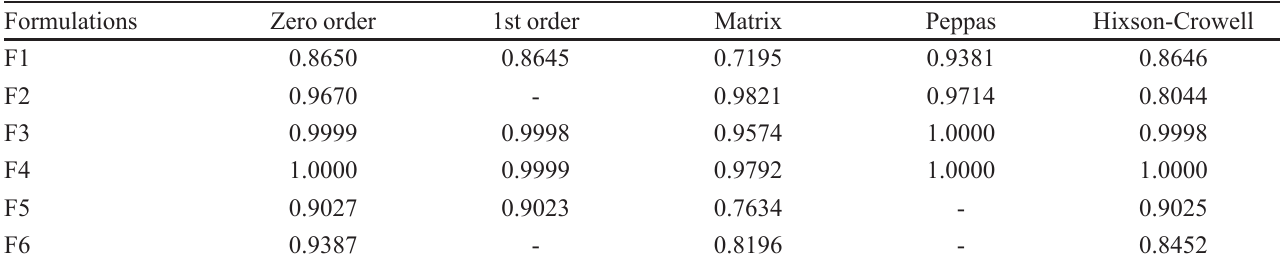
TABLE III - Correlation coefficients (r) for Hot-Melt Enteric coated Diclofenac sodium pellets